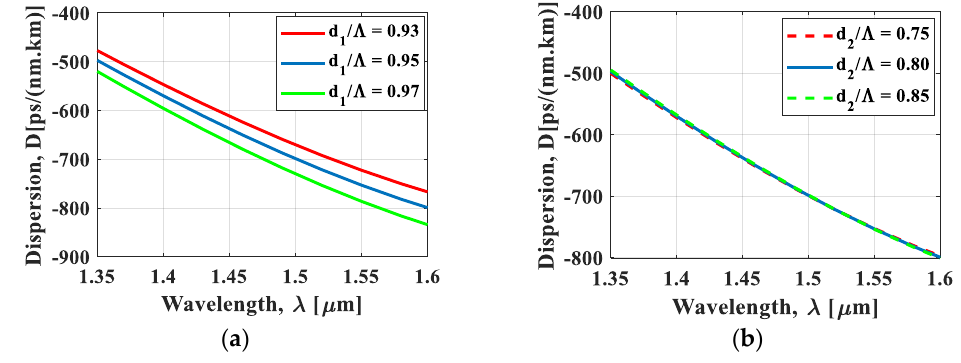
Figure 4. ( a ) Wavelength dependence dispersion curve for the slow axis and fast axis; ( b ) effect on dispersion upon varying the value of pitch ( Λ ) from ±1 to ±2%.